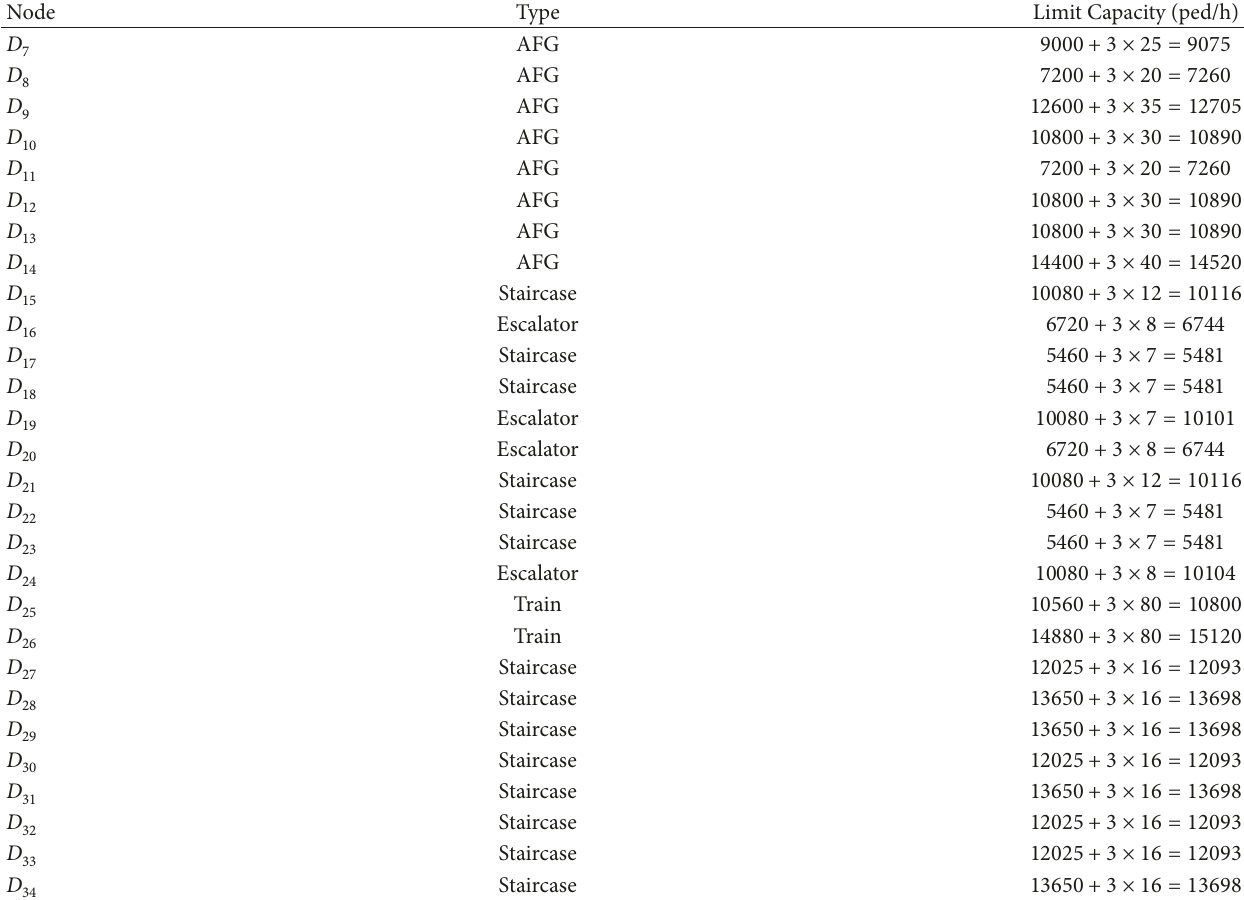
Table 2: The Limit capacity of nodes.